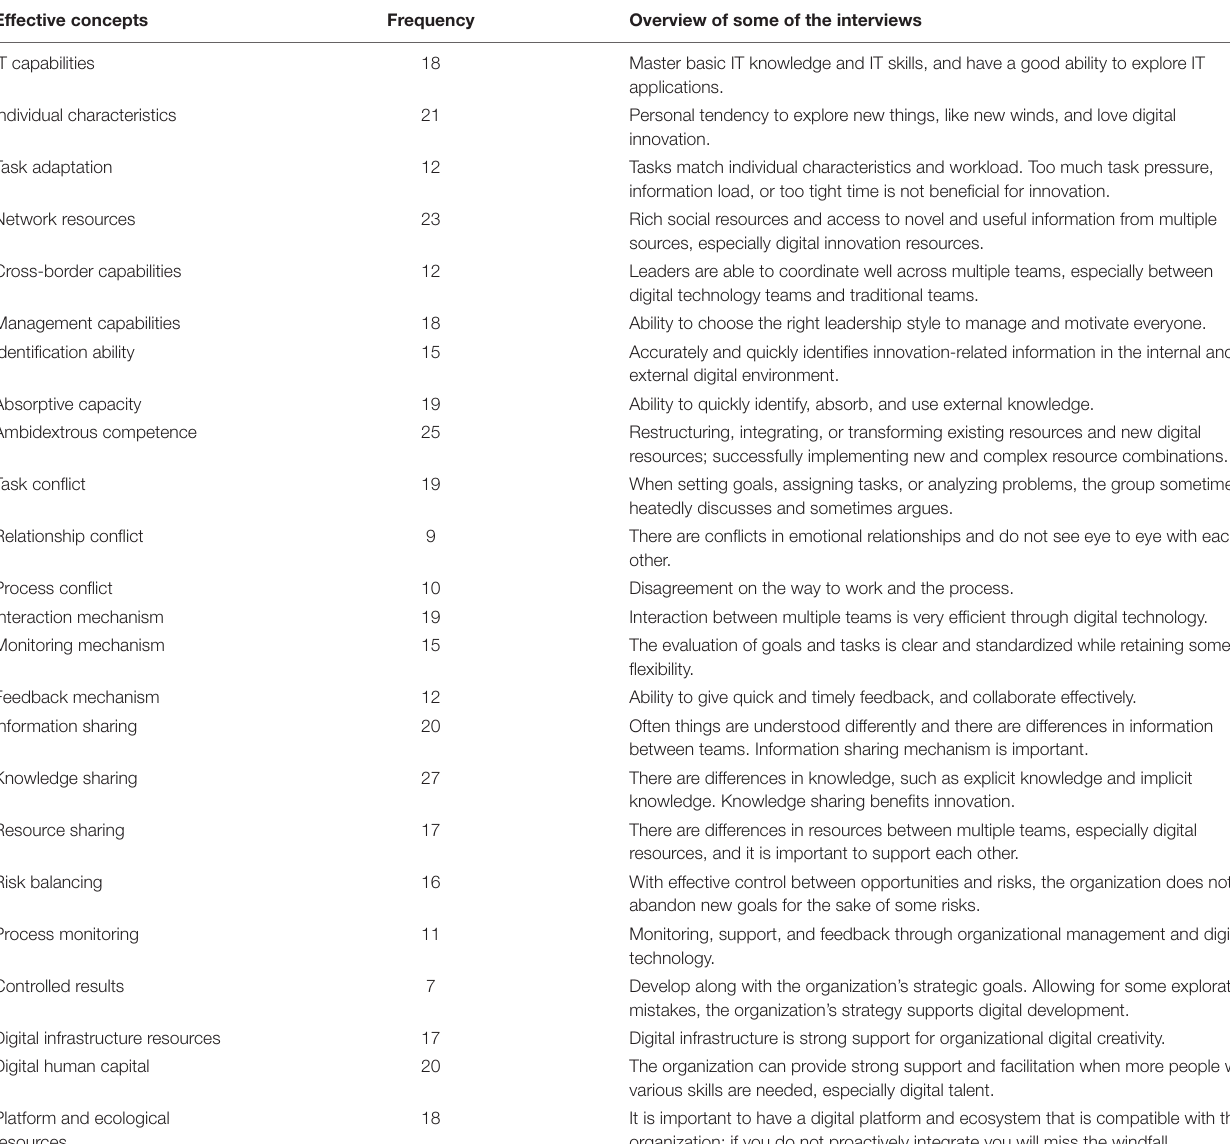
TABLE 1 | Coding database of some interview contents in the action